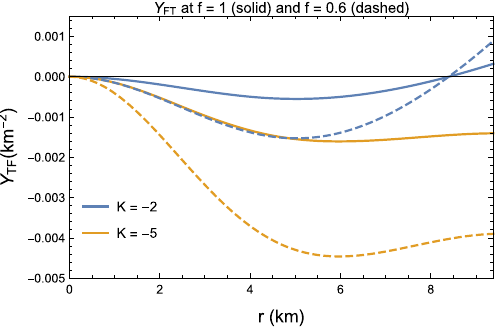
Fig. 3 Complexity factor versus co-moving radial coordinate